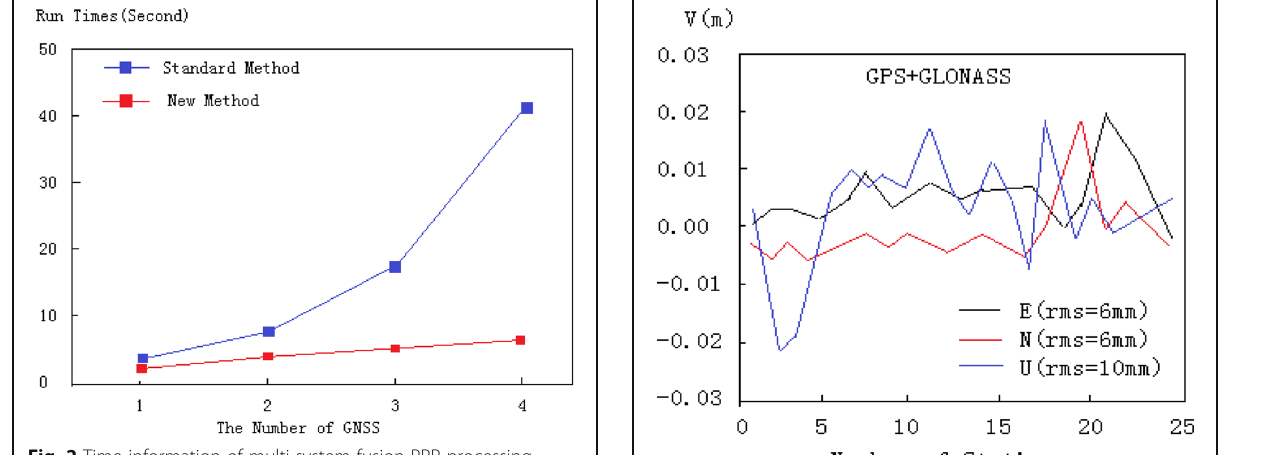
Fig. 2 Time information of multi-system fusion PPP processing carried out by two methods Fig. 3 Positioning result deviation and RMS value of case 1